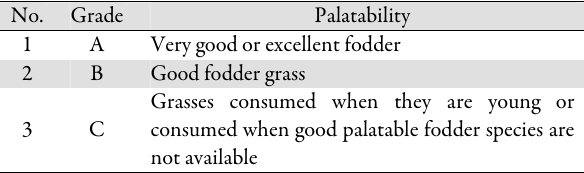
Tab. 2. The palatability grades of grass species based on animal preferences No.